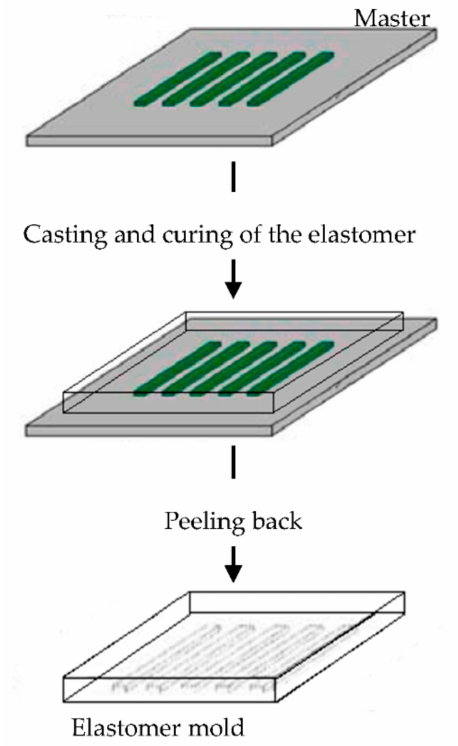
Figure 6. Schematic illustration of the procedure for building poly(dimethylsiloxane) (PDMS) molds for soft lithography. Modified from [94]. CC BY-NC-ND